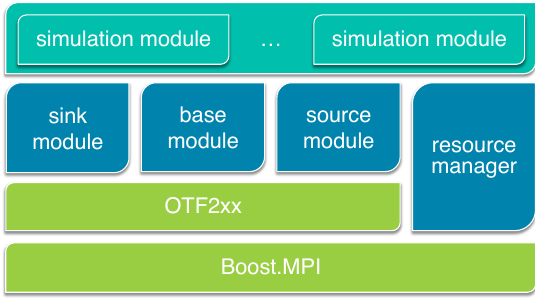
Figure 1: Overview of the HAEC-SIM